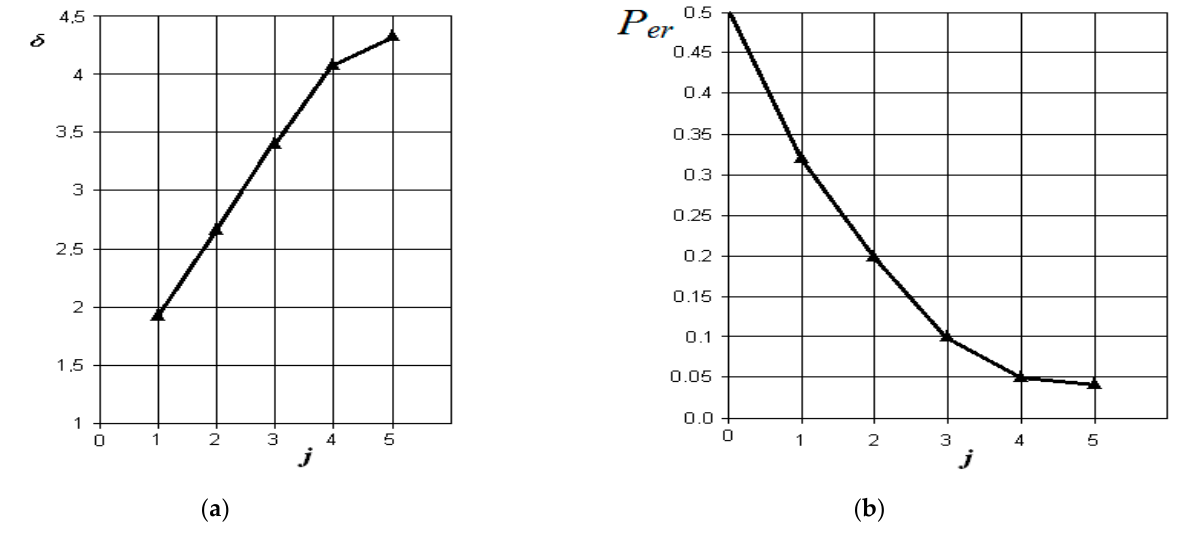
Figure 9. The results of discriminant data analysis when comparing the norm with exacerbated chronic odontogenic sinusitis: ( a ) the dependence of the increase in the normalized Euclidean distance as signs are added to the discrimination model δ = f ( j ) ; ( b ) the dependence of the decrease in the probability of decision-making errors as features are added to the discrimination model = f ( j ) : j = 5-is the dimension of the space of informative